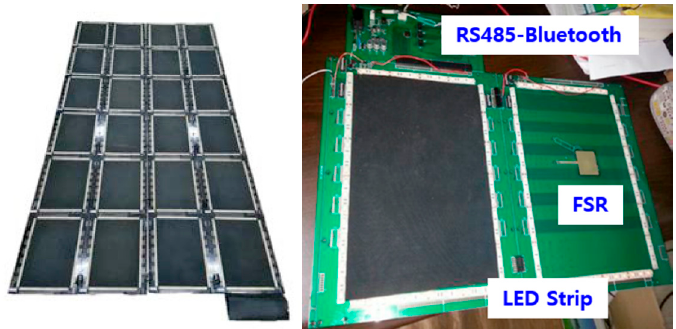
Figure 3. The square mat system, consisting of control, sensing, and communication modules.